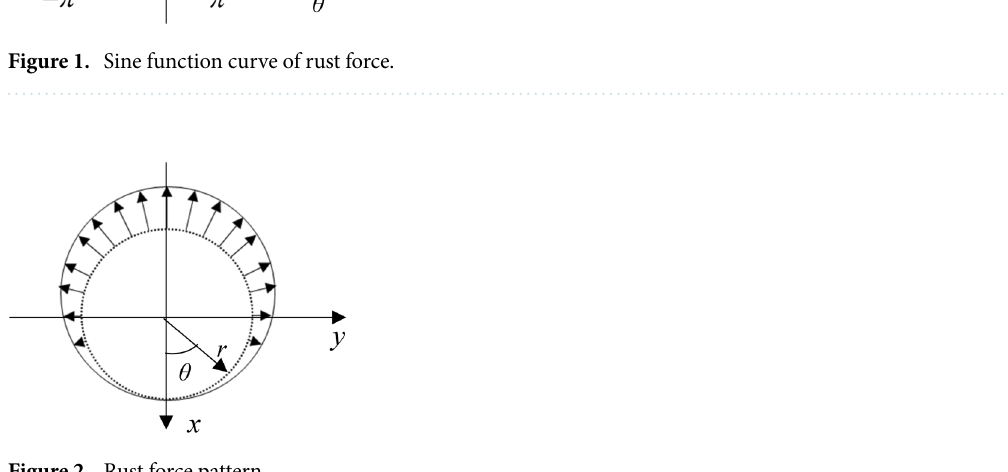
Figure 2. Rust force